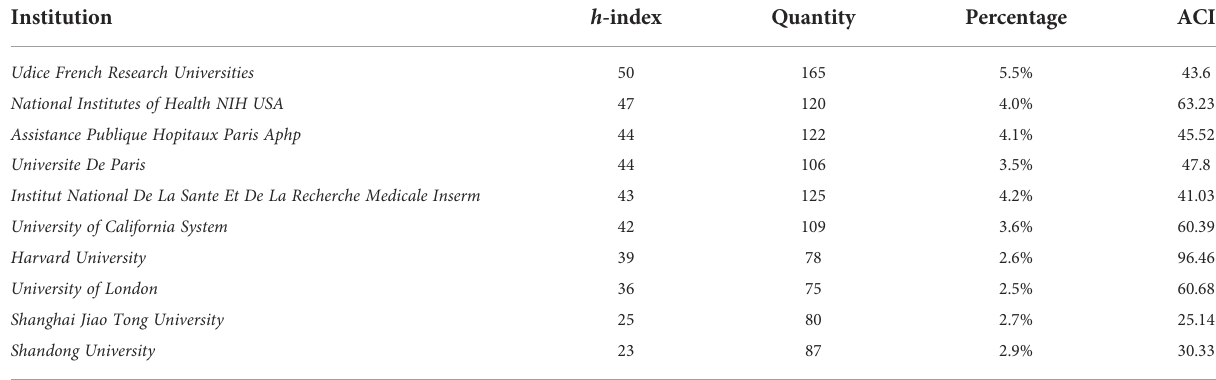
TABLE 2 Top 10 institutions in the studies of POI rank in order by h